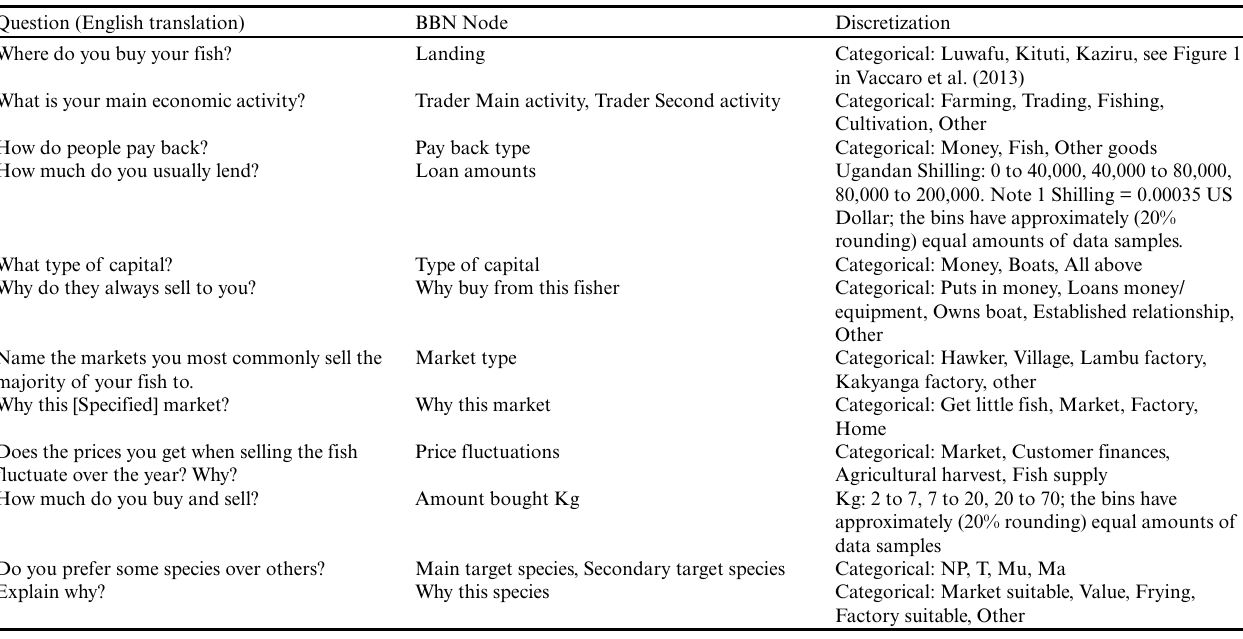
Table 2 . Trader’s questions used in Bayesian Belief Network (BBN) and the discretization for Figure 4. Question (English